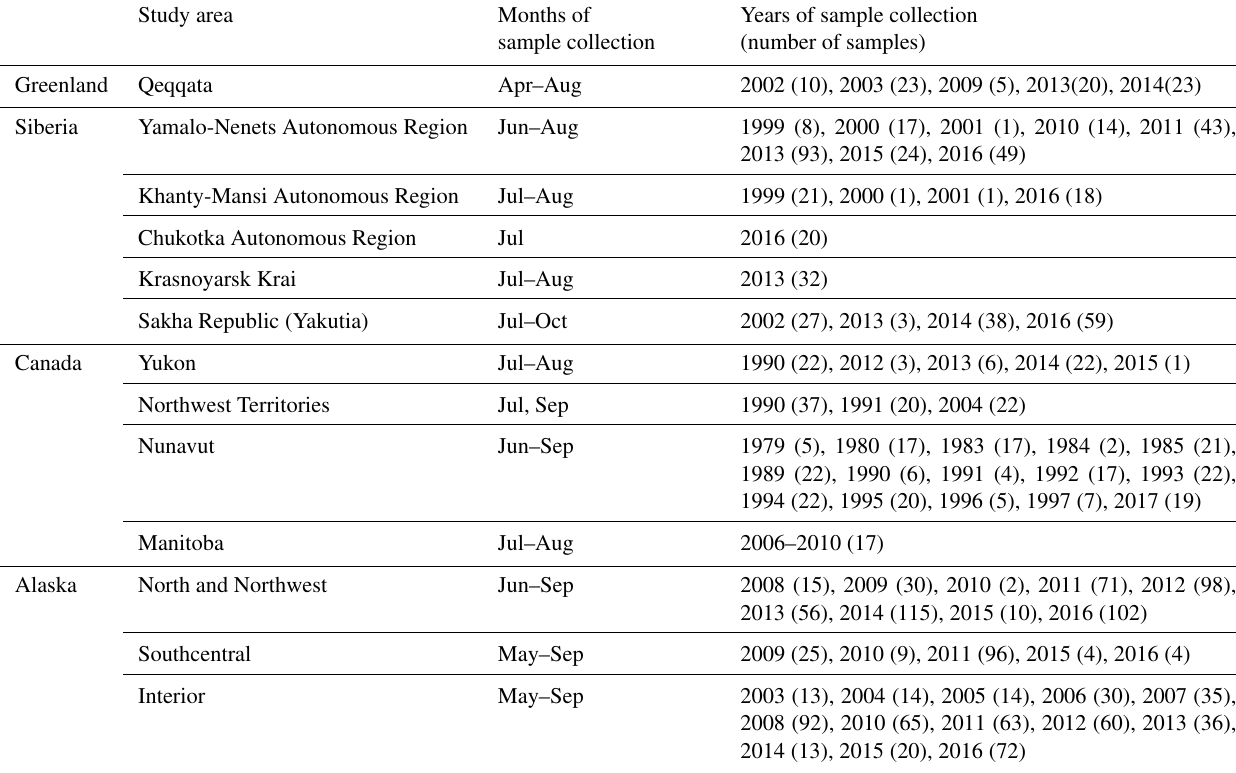
Table 1. Overview of temporal sample distribution for each study area. Numbers in brackets are numbers of samples collected in each year. Study